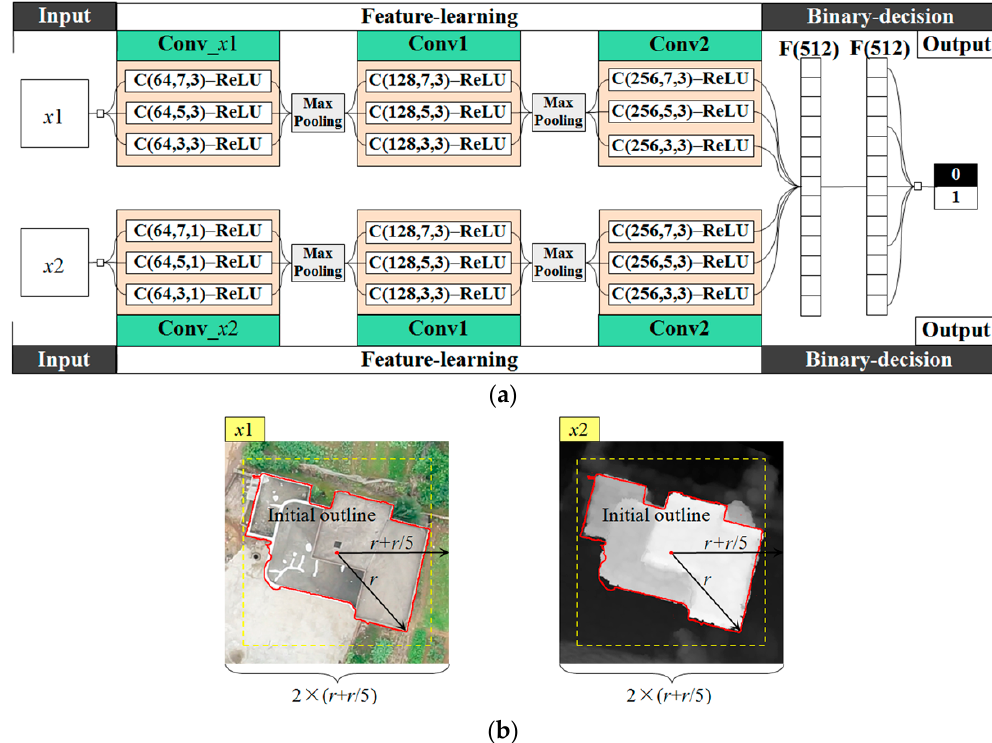
Figure 8. Architecture of MSCNs. In ( a ), C( n , k , m ) denotes the convolutional layer with n filters of spatial size k × k of band number m . Each max-pooling layer with a max filter of size 2 × 2 of stride 2 is applied to downsample each feature map. F ( n ) denotes a fully connected layer with n output units. ReLU represents the activation functions using the rectified linear unit σ ( x ) = max ( 0, x ) . As shown in ( b ), x 1 and x 2 with same size denote the true-color RGB ( m = 3) and height intensity ( m = 1) patches, respectively; the extents of x 1 and x 2 are defined on the basis of the external square and bu ff er of the initial outline of a ground object, and x 1 and x 2 are resampled to a fixed size as input, e.g., a fixed size of 127 × 127 pixels used in this study.